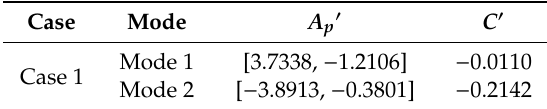
Figure 5. Clustering results of case 1. Table 2. The estimated values of the simplified model parameters of case 1.